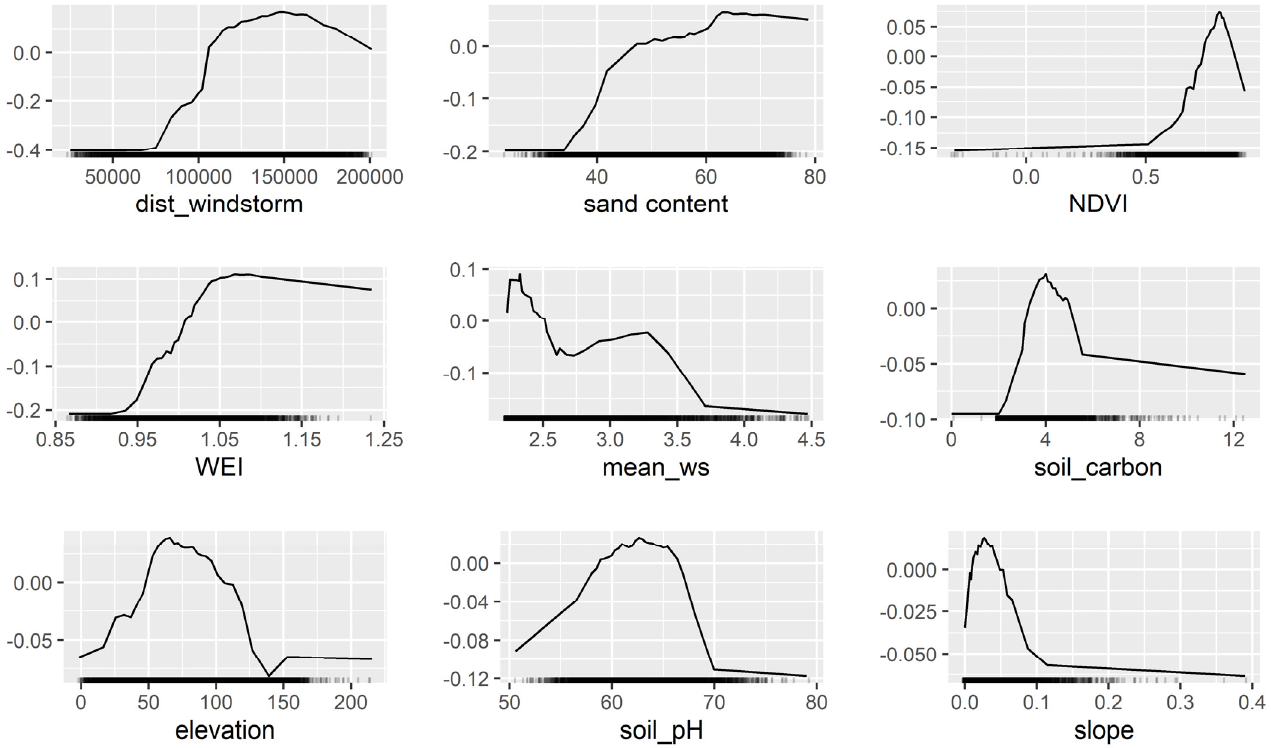
Figure 5. Accumulated Local Effects (ALE) plots for the most important features of the RF model. The X ‐ axis represents predictors values while the Y ‐ axis represents probability. Abbreviations: dist_windstorm—distance from the windstorm Klaus trajectory, sand—sand fraction content, NDVI—Normalized Difference Vegetation Index, WEI—Wind Exposition Index, mean_ws—